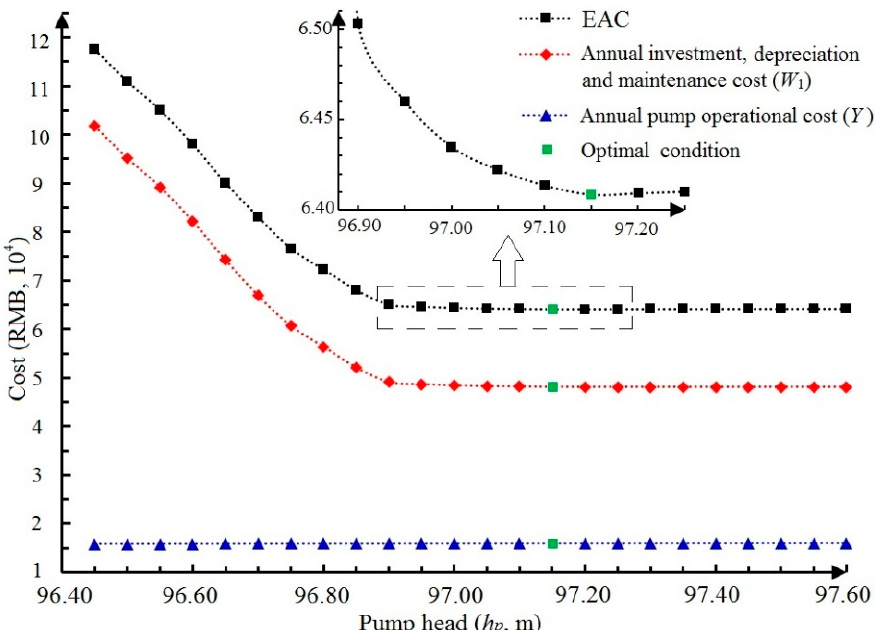
Figure 4. Cost distribution at different pump heads ( h p ). EAC is the sum of annual investment, depreciation and maintenance cost ( W 1 ) and annual pump operational cost ( Y ). The optimal pump head ( h p ) of minimum EAC ( W ) was 97.15 m. Table 2. Optimization results of diameters in each branch section.